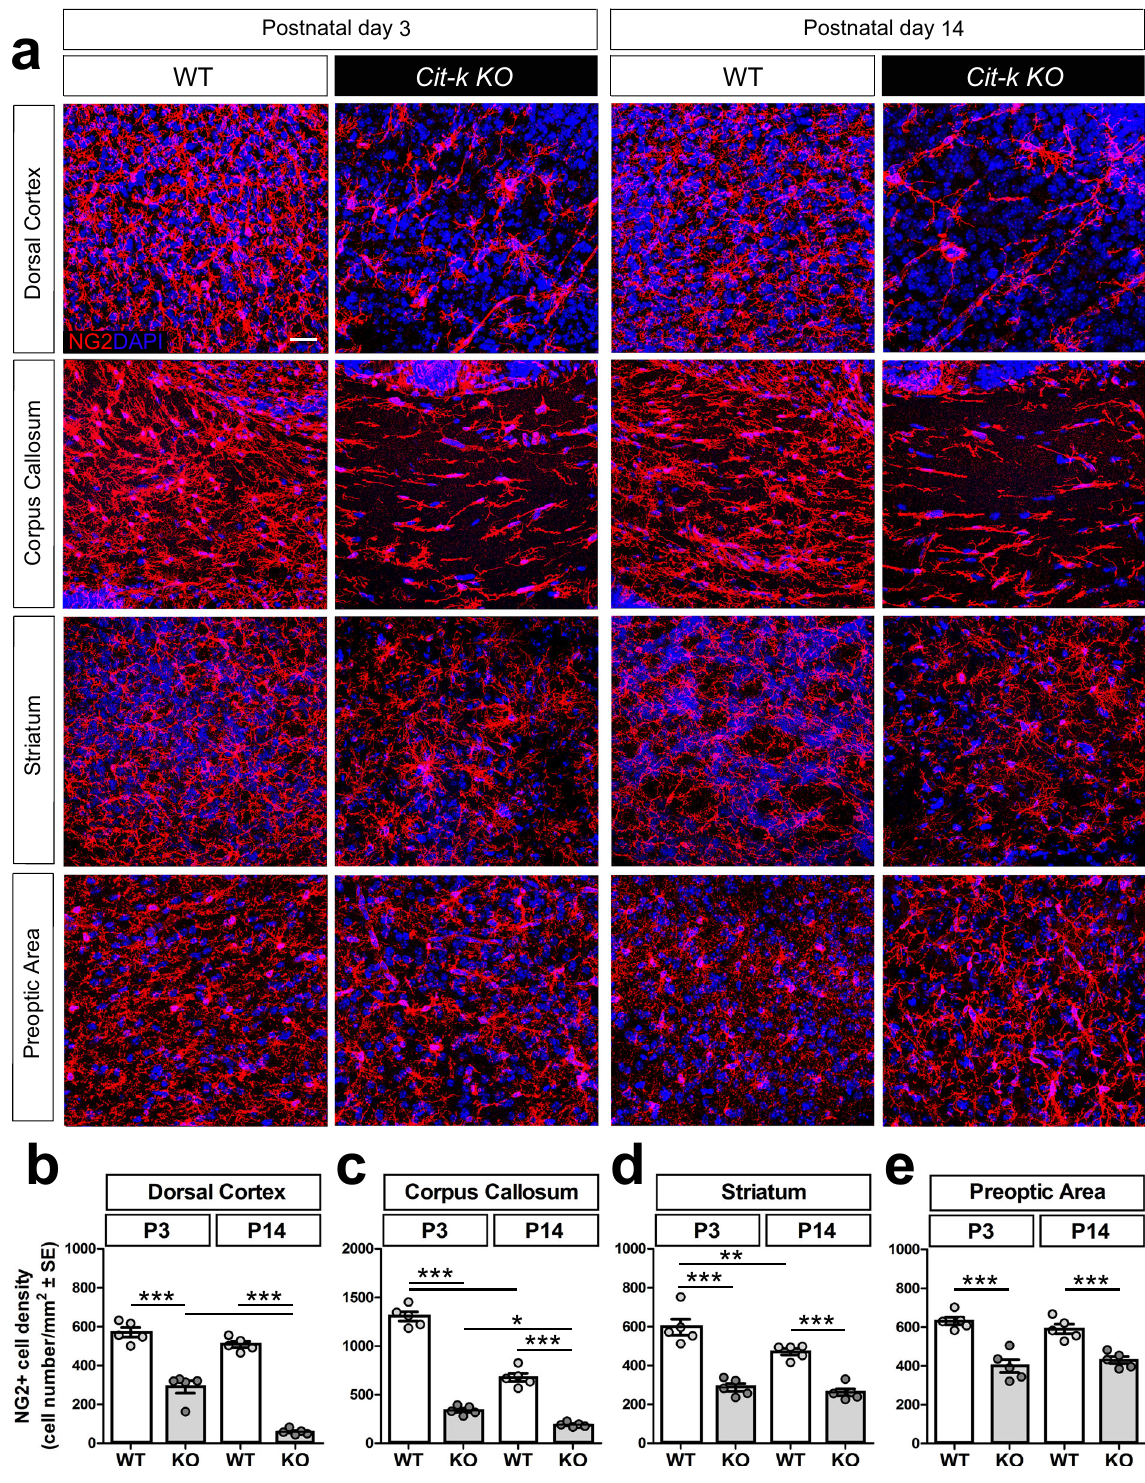
Fig. 2 Cit-k loss differentially affects dorsal and ventral OPCs in the postnatal mouse forebrain. a NG2 + (red) cells in distinct regions of WT vs. Cit-k KO mouse forebrain. DAPI (blue) counterstains cell nuclei. Scale bar: 20 µ m. b – e NG2 + cell density in the dorsal cortex ( b ), corpus callosum ( c ), striatum ( d ), and preoptica area ( e ) at P3 and P14 ( n = 5 each; Two-way Anova followed by Bonferroni ’ s Multiple Comparison Test, Dors. Ctx: Genotype effect: P < 0.0001; Time effect: P < 0.0001; Genotype × Time: P = 0.0013. CC: Genotype effect: P < 0.0001; Time effect: P < 0.0001; Genotype × Time: P <